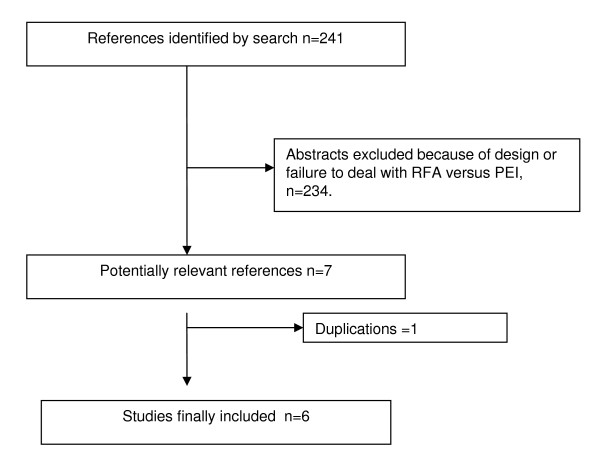
Flow diagram for study selection and inclusion.